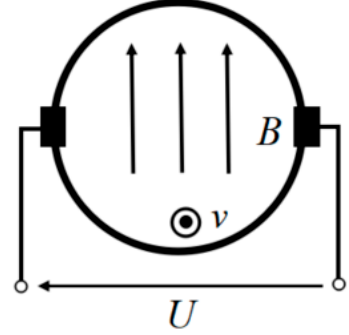
Figure 1. The schematic diagram of induced potential.